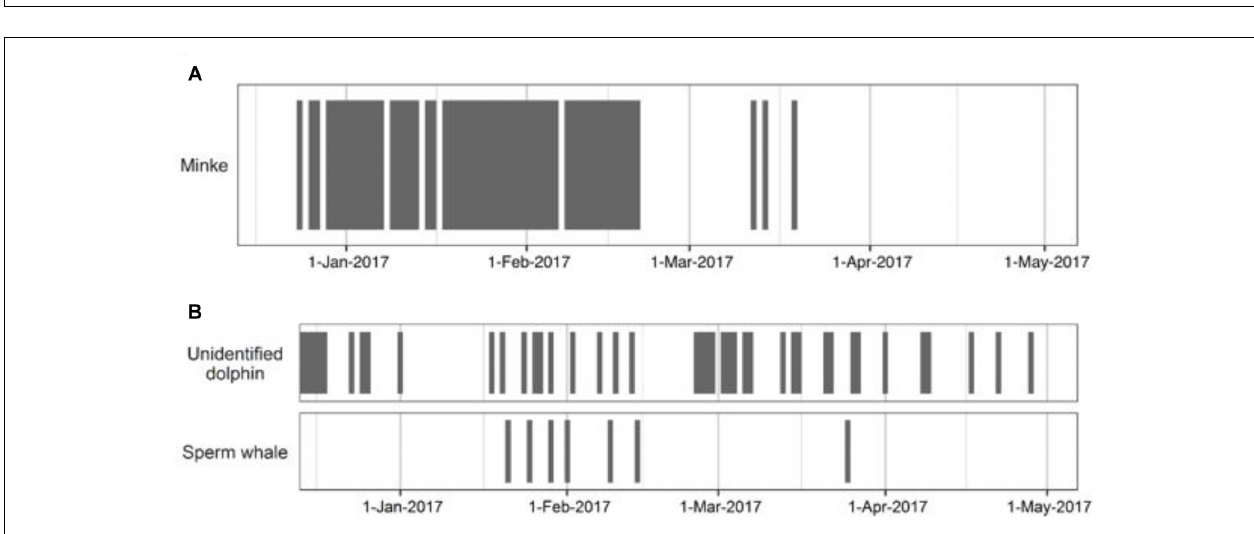
FIGURE 2 | Seasonal occurrence of humpback whale song from December 2016 to Jun 2017 across all recording sites, shown from north (top) to south (bottom) . Dark gray bars indicate recording dates with humpback song present; light gray shading indicates periods with no recording effort. Recordings were collected continuously at all sites except for St. Martin, where a 25% duty-cycle (1 h/4 h) was used.